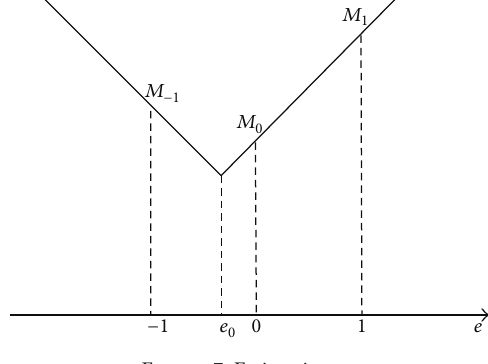
Figure 7: Estimating 𝑒 0 .